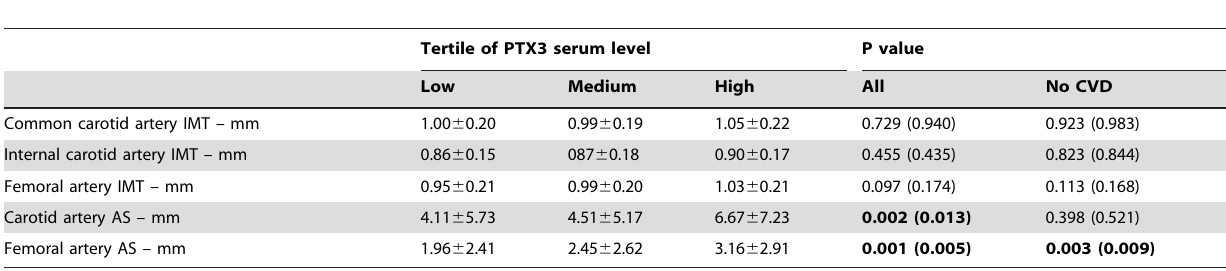
Table 3. Measures of carotid and femoral artery atherosclerosis according to PTX3 tertile groups in the Bruneck